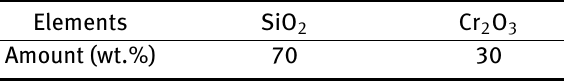
Table 3: Chemical compositions of NFC.